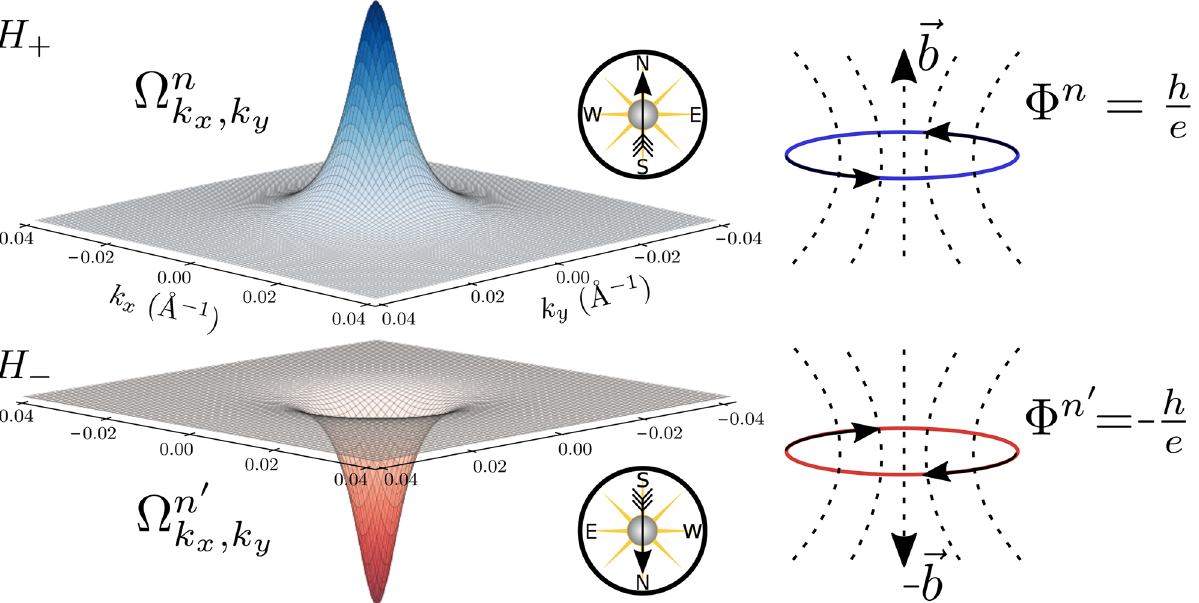
Figure 2. Non-trivial Berry curvature and effective flux quantization in TIs. Non-trivial ( M < 0 , B < 0 ) Berry curvature (cid:31) k for the positive energy eigenstates of H ± labelled as | n � and | n ′ � respectively. The compass x , k y indicates the orientation of the field felt by the electrons on each band. In the bulk of a TI, this curvature allows considering the existence of helical orbits with an associated flux � = h / e C , being C = ± 1 the Chern number associated to the conduction bands of H ±